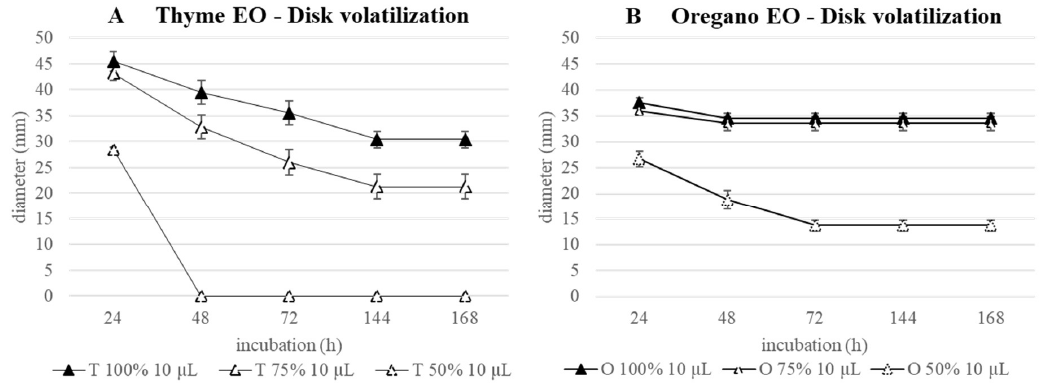
Figure 7. Disk volatilization test against S. epidermidis : results obtained with 10 µL of thyme ( A ) and oregano ( B ) EOs during 168 h of incubation.